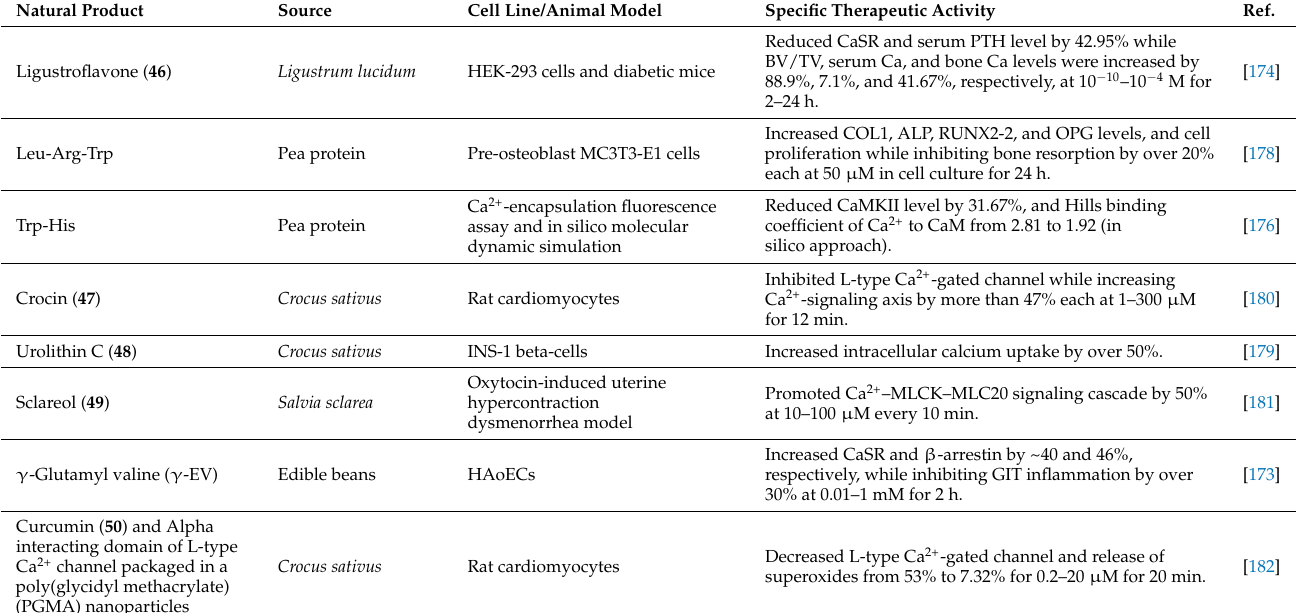
Table 3. Natural products targeting the calcium signaling axis with potent relevance to bone